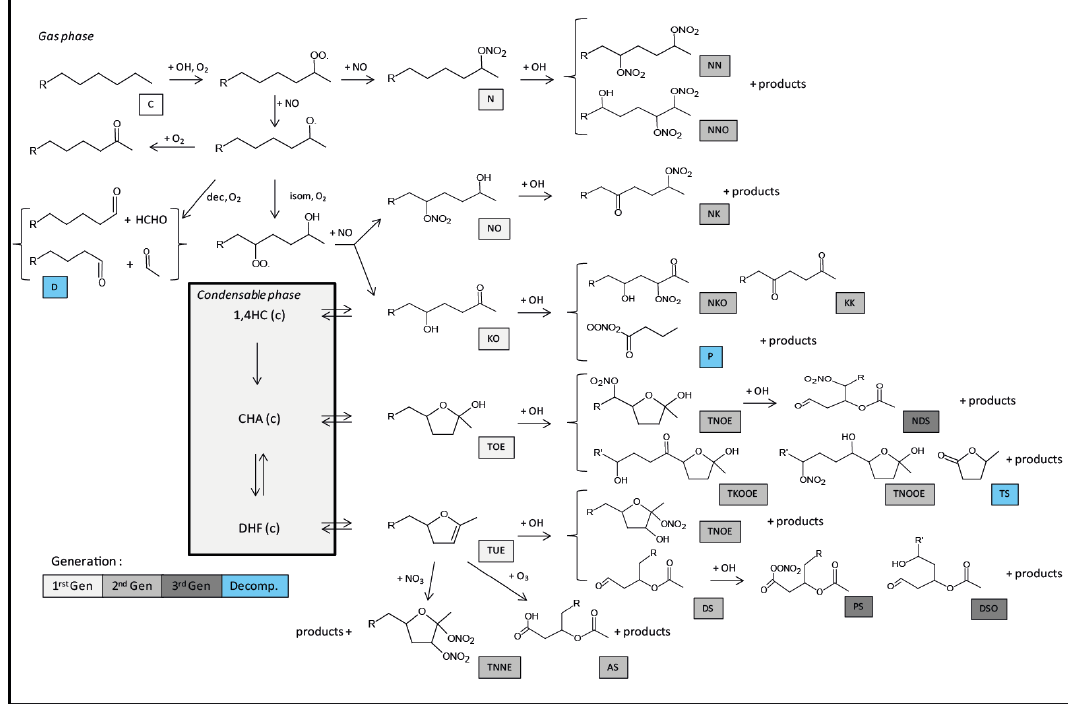
Figure 9. Generic GECKO-A chemical mechanism leading to the major products formed during n-alkane gaseous oxidation under high-NO x conditions.